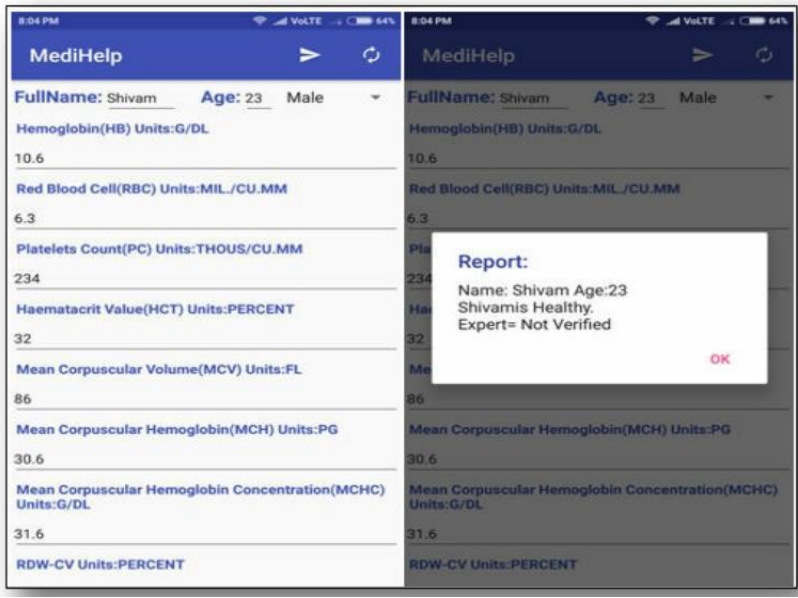
Figure 7. The user interfaces to fill in the details of user 2.